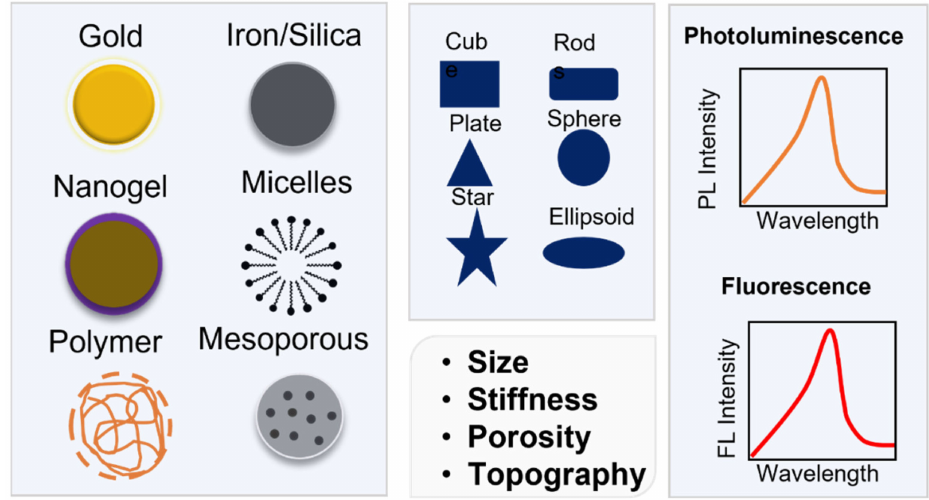
Figure 1. Physicochemical characteristics of nanoparticles.